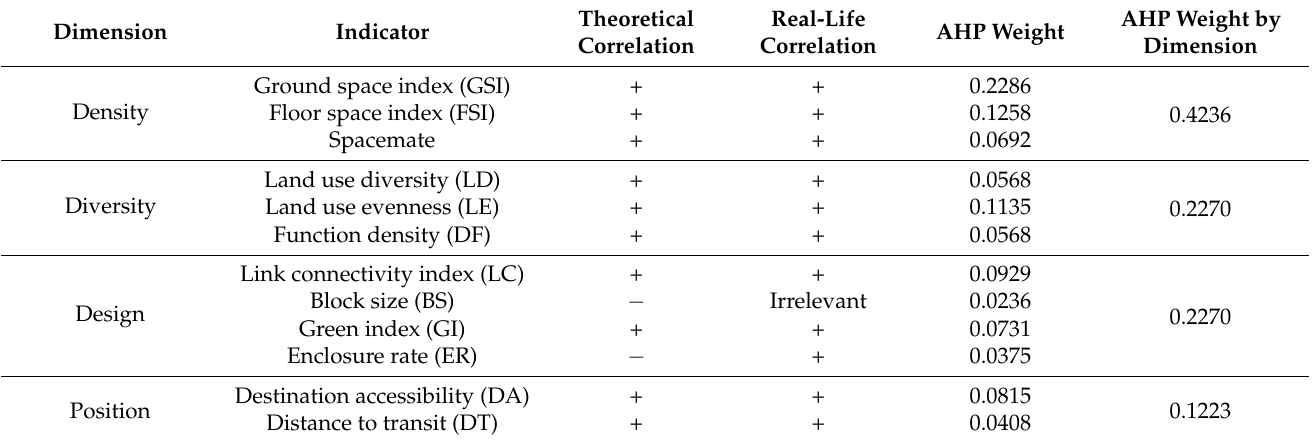
Table 7. Comparison between theoretical and realistic scenarios of ‘5d’ indicators on urban